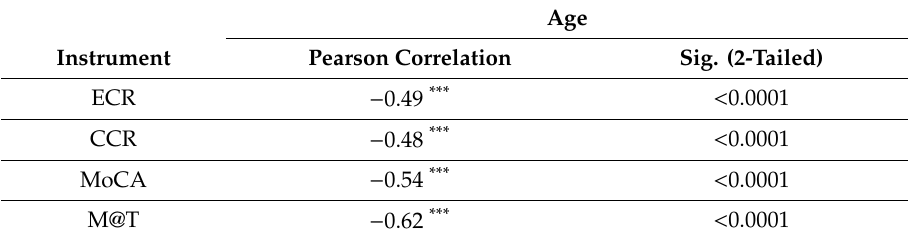
Table 4. Correlations between age and cognitive reserve.